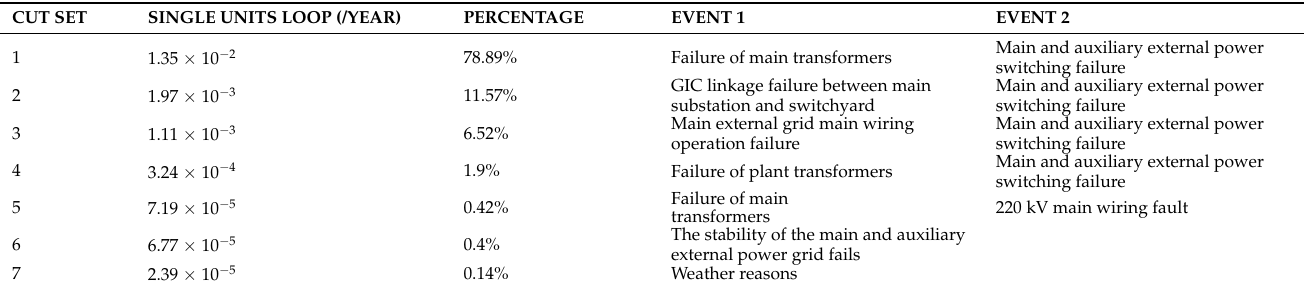
Table 3. Minimum cut set for LOOP occurrence in a single unit.